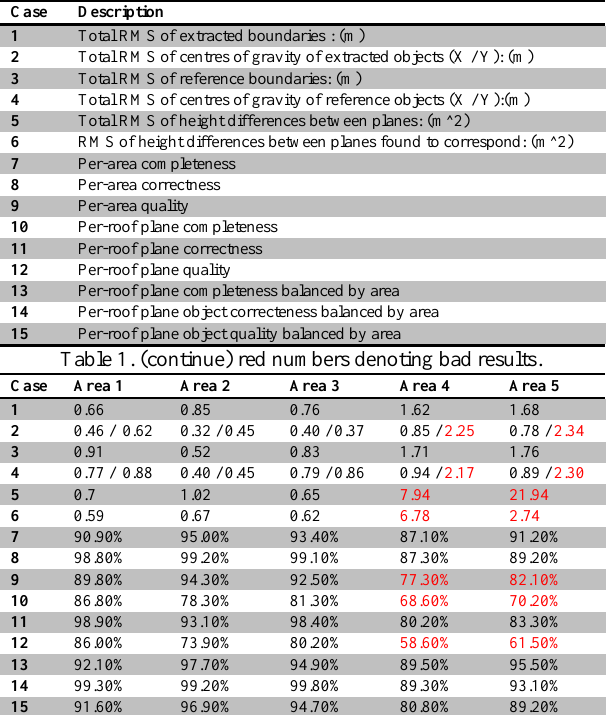
Table 1. Statistics of overall accuracy evaluation from ISPRS.